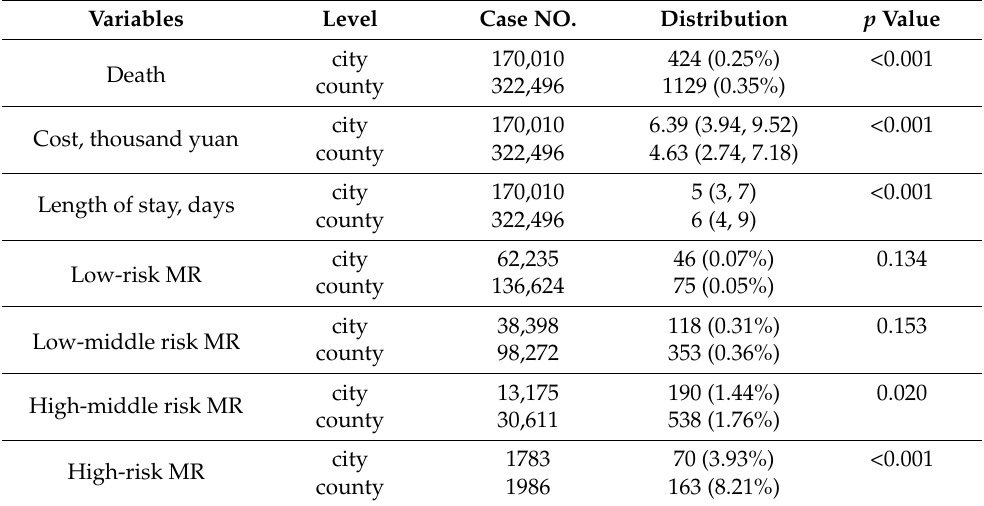
Table 3. Differences between the two levels of hospitals in terms of mortality rate, cost, and length of